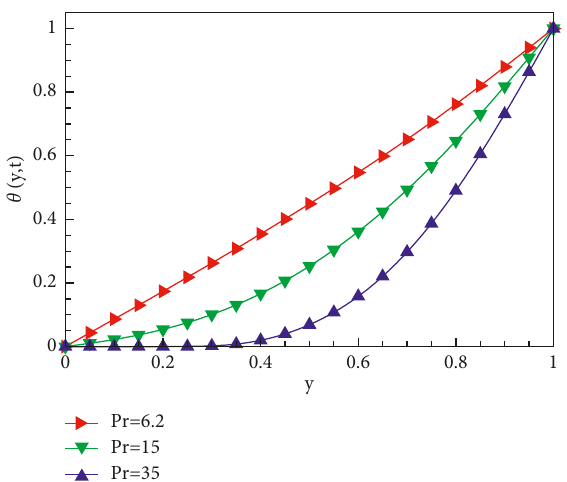
Figure 10: Influence of Pr on θ when α � β � 1 , λ α